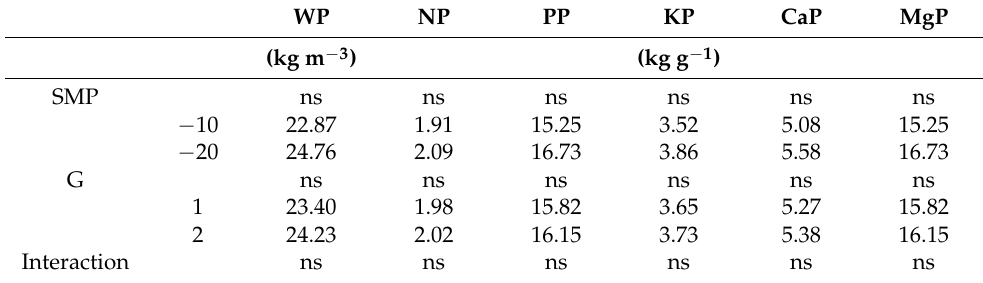
Table 6. Water productivity (WP) (kg of commercial fruit per m 3 of water applied) and nutrients productivity (kg of commercial fruit per kg nutrient applied). NP: Nitrogen productivity, PP: Phos- phorus productivity; KP: Potassium productivity, CaP: Calcium productivity and MgP: Magnesium